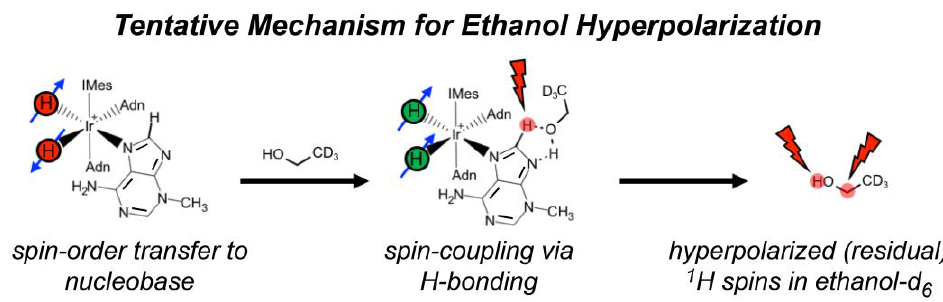
Figure 5. Illustration of the proposed mechanism for hyperpolarization of residual protons of deuterated ethanol solvent molecules. In this scenario, bound 3-methyladenine becomes hyperpolarized, deuterated ethanol (with residual 1 H spins) hydrogen-bonds to 3-methyladenine, and then the solvent molecule becomes hyperpolarized via spin-relayed SABRE.